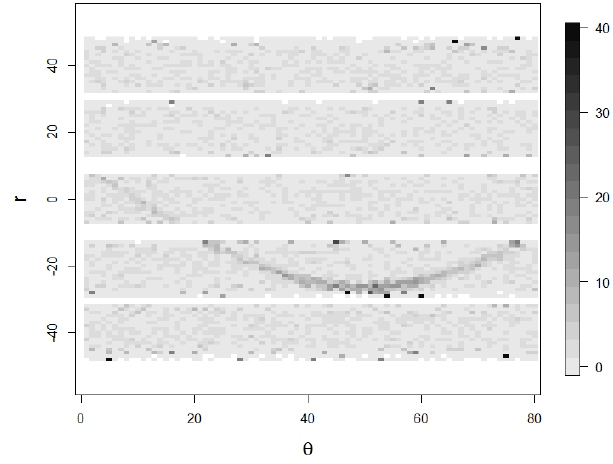
Figure 2. One typical sinogram of ClearPET (count number vs. ra- dial ( r ) and azimuthal ( θ ) coordinate), showing gaps between the